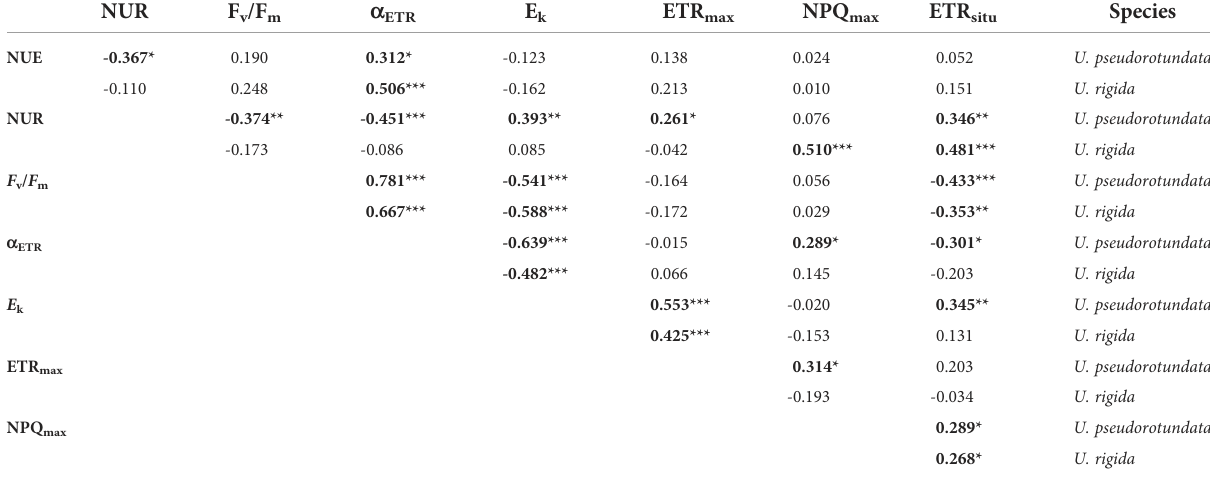
TABLE 2 Spearman correlation values between nitrate bio fi ltration parameters and photosynthetic parameters obtained from U. pseudorotundata and U. rigida cultivation under two experimental conditions: (1) 50% fi sh ef fl uent and (2) 100% fi sh ef fl uent.